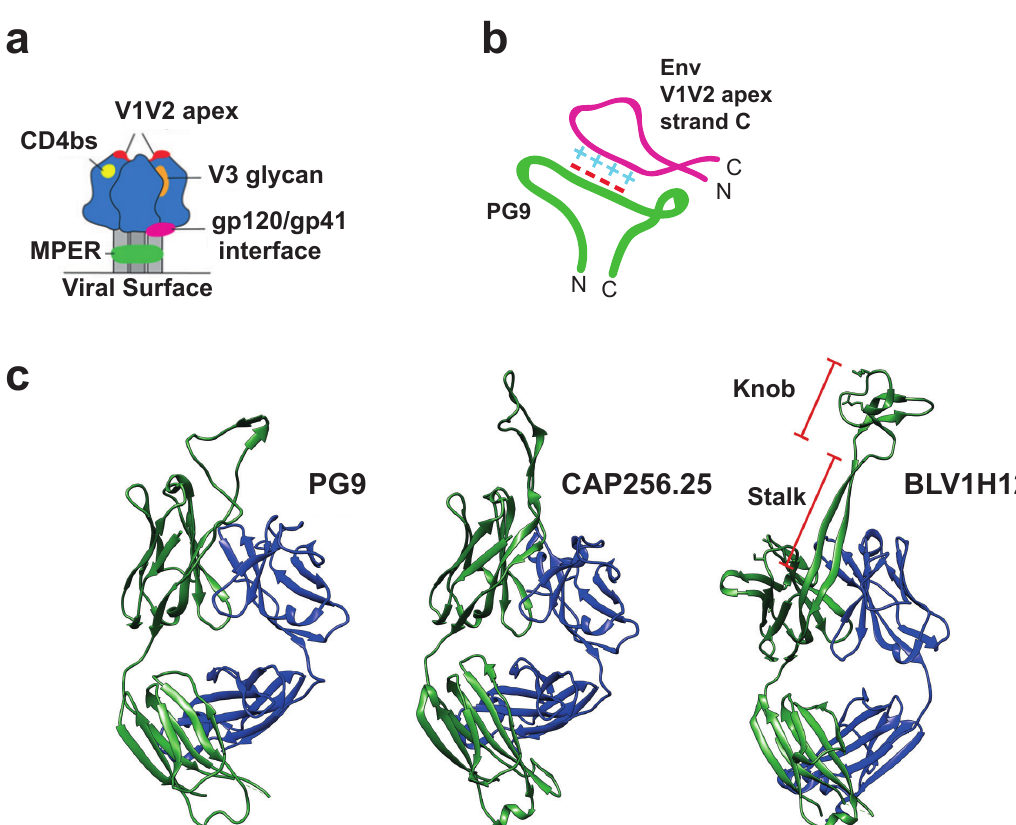
Figure 4. Extended CDR H3 structures generate unusual antigen binding sites. ( a ) A cartoon showing the five main epitopes on trimeric HIV-1 Env that are vulnerable to antibody-mediated neutralization. Depicted are: the CD4 binding site (CD4bs; yellow), membrane-proximal external region (MPER; green), the interface between gp120 and gp41 (pink), the V3 glycan supersite (orange) and the V1V2 apex (red), where the latter is the most distal from the viral surface. ( b ) A cartoon depicting the unusual structure of the CDR H3 of PG9 in contact with its epitope. The long anionic loop generates extensive electrostatic interactions with a conserved cationic region of HIV-1 Env. This interaction confers broad neutralization as long as the charge is conserved. ( c ) Structures of two human anti-HIV-1 BNAbs, PG9 (PBD: 5VJ6) and CAP256.25 (PDB: 5DT1) show that their CDR H3s extend away from the main antibody structure. The cow ultralong antibody BLV1H12 (PDB: 4K3D) is included for comparison, with the stalk and knob regions